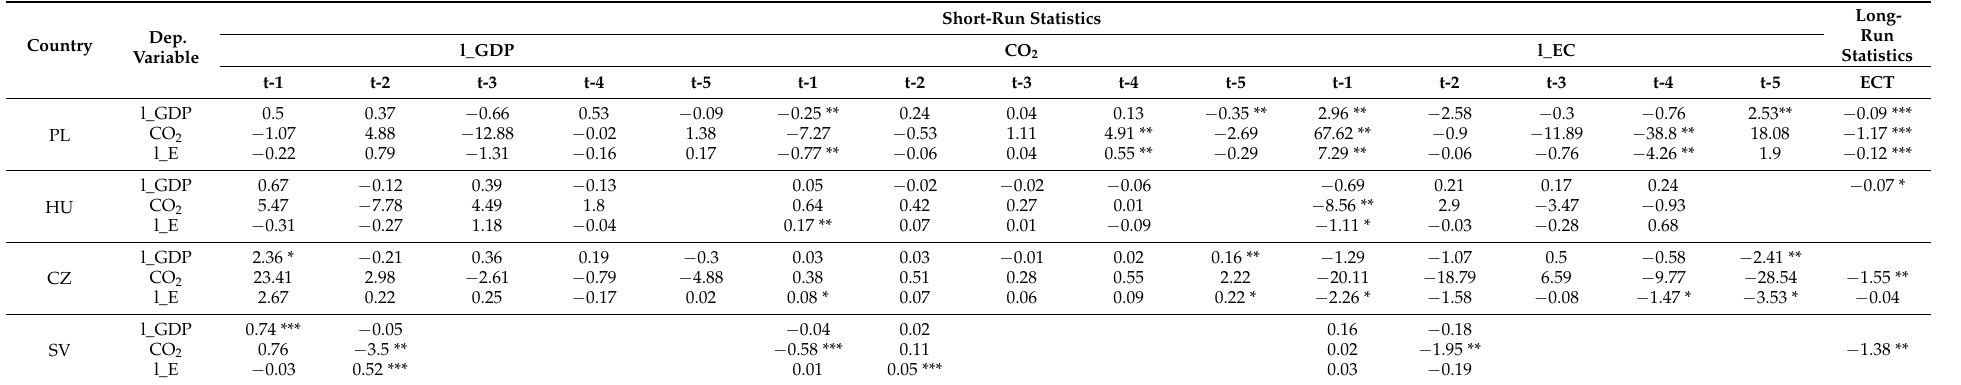
Table 6. The ARDL bound testing for cointegration with critical